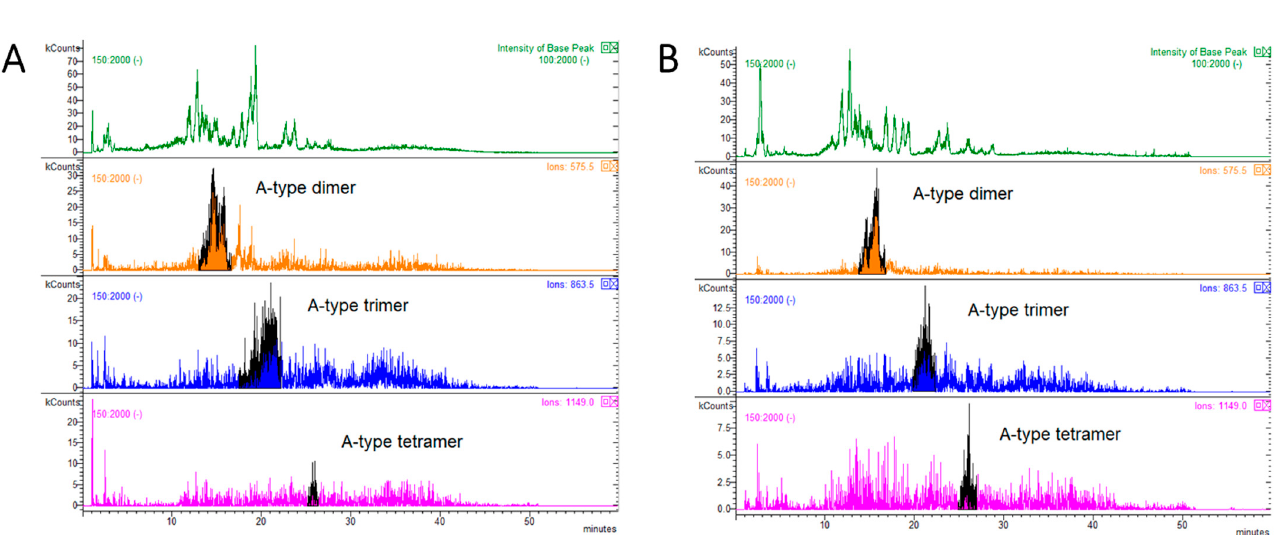
Figure 4. HPLC-MS chromatograms showing the distribution of type-A procyanidins in dry larch bark powder (panel A ) and larch bark extract (panel B ).